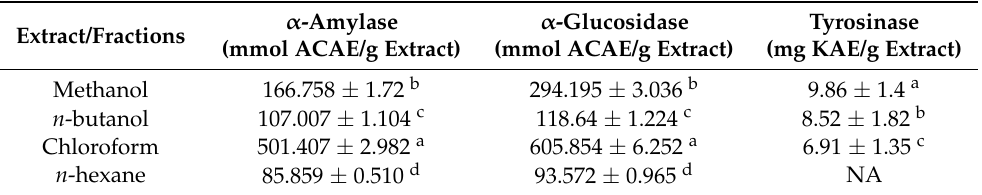
Table 6. Enzyme inhibition results of S. glutinosus whole plant extract/fractions. α Extract/Fractions